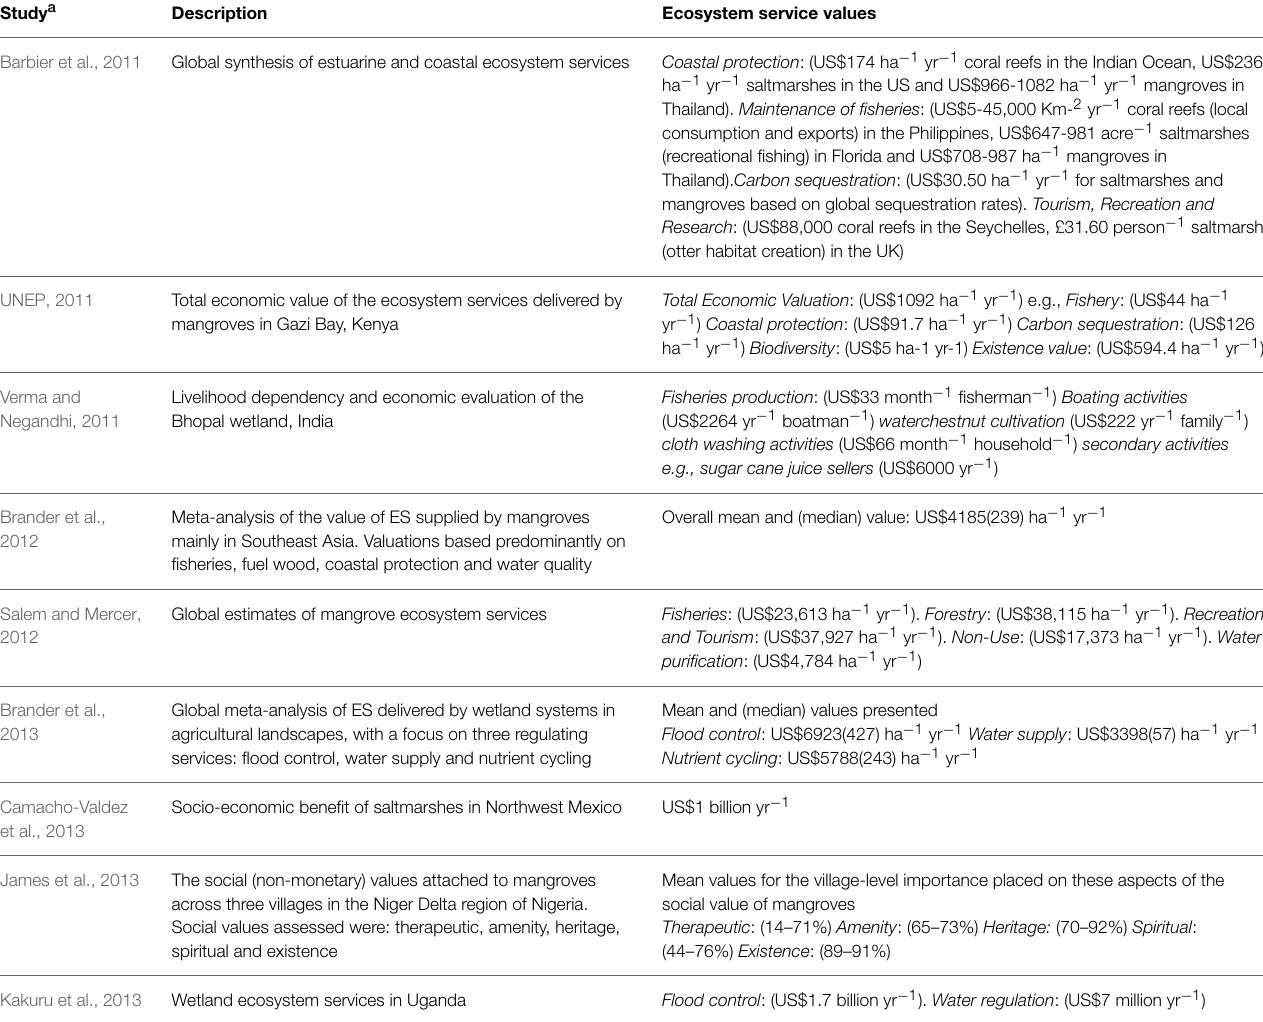
TABLE 3 | Valuation studies of coastal and wetland ecosystem